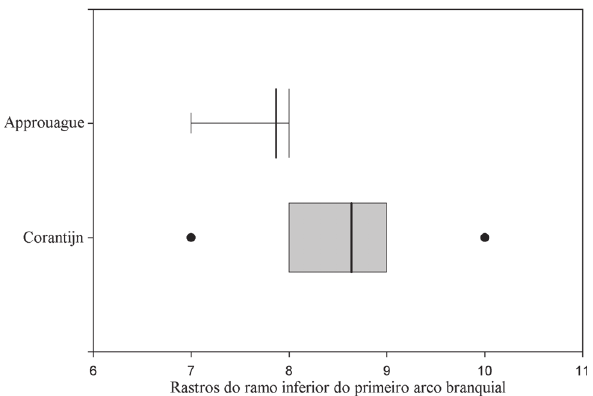
Figura 24. Variação do número de rastros do ramo inferior do pri- meiro arco branquial nas populações de P. wayana do Rio Corantijn e do Rio